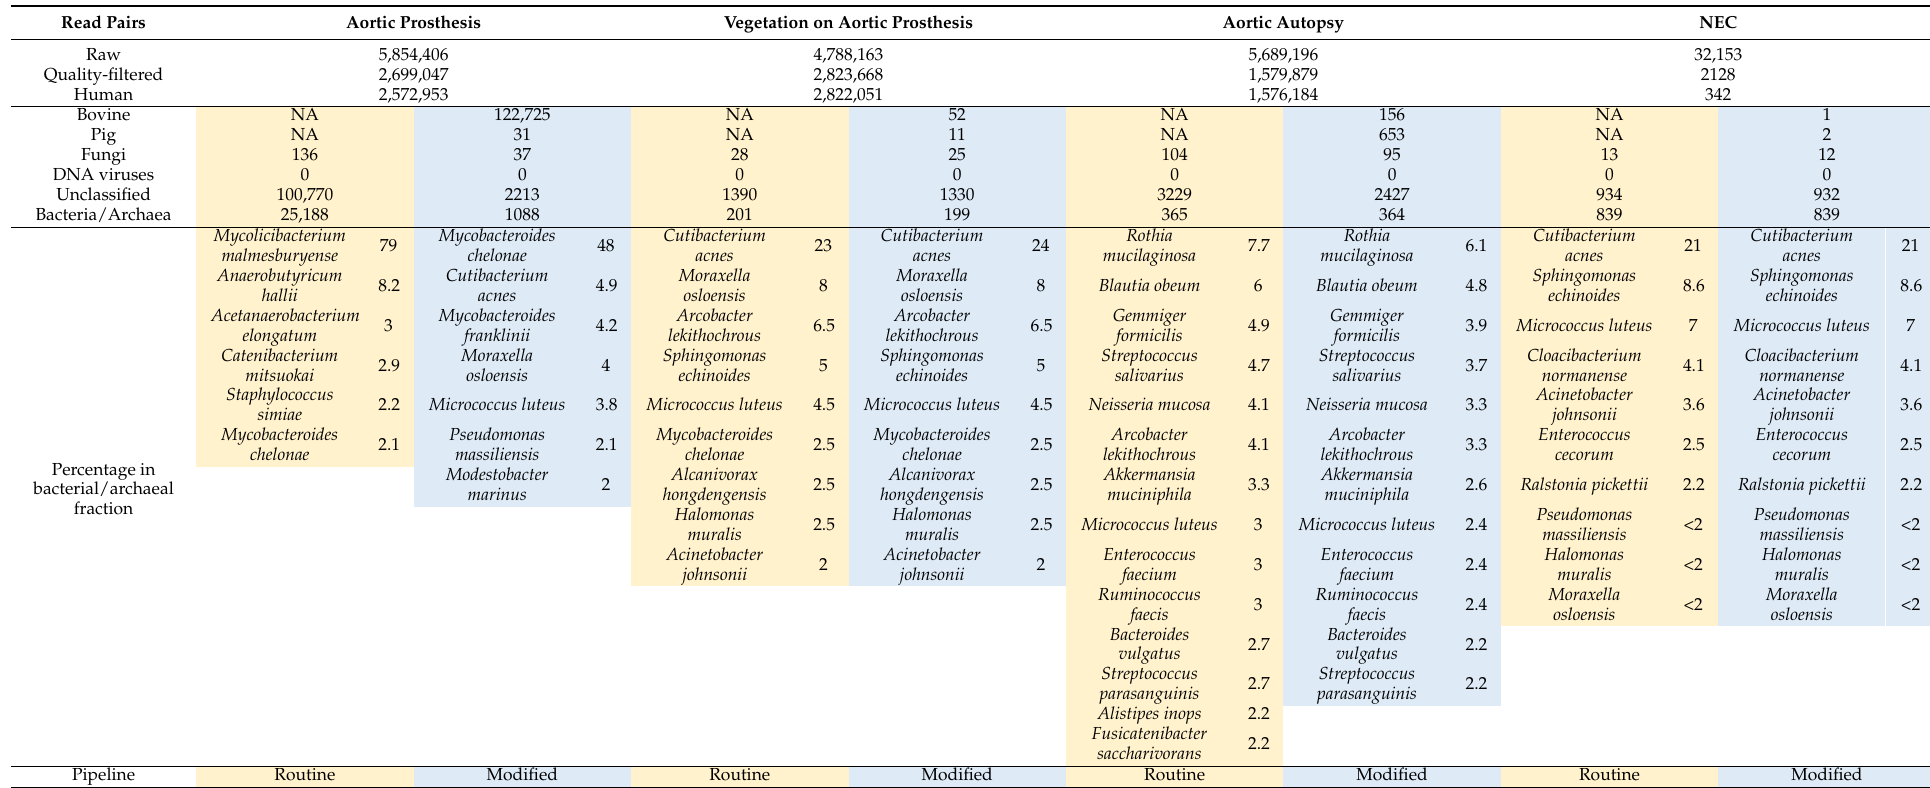
Table 2. Number of read pairs obtained by mNGS) and their taxonomic assignments at various steps of data analysis. NCBI taxonomy was used for CLARK- based species assignments. In this taxonomy, some species of the genus Mycobacterium were reassigned to the four new genera including Mycobacteroides and Mycolicibacterium . In the bacterial fraction, species with the relative abundance of reads >2% are presented. Several species of interest in the NEC under this threshold are also indicated. Yellow background: routine pipeline, blue background: modified